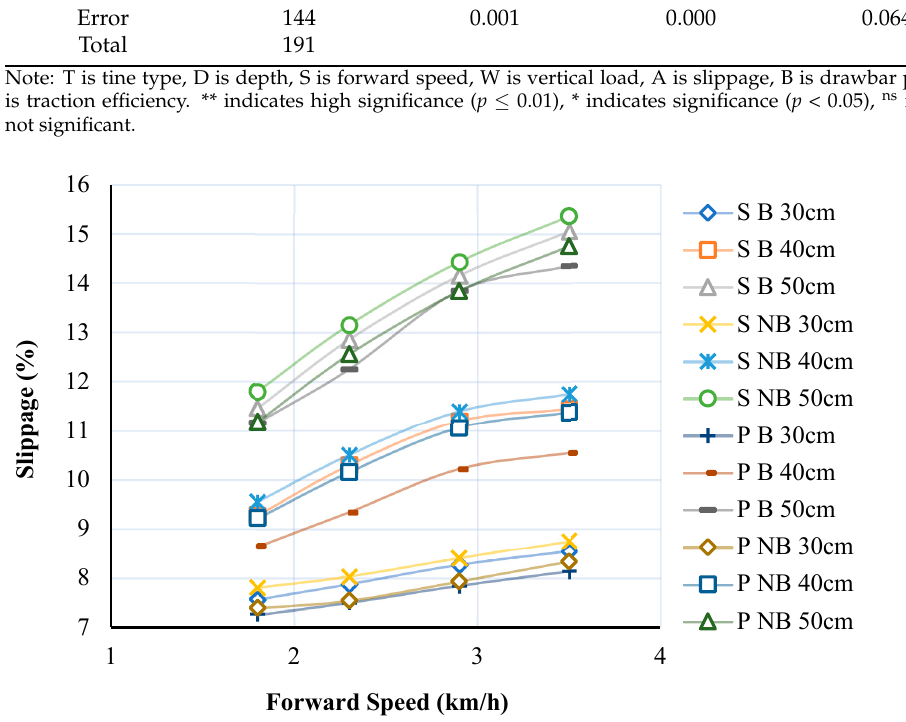
Figure 3. The relationship between speed, depth, ring weights and slippage using the studied tines (S-Subsoiler, P—Paraplow, B—225 kg vertical load, NB—No Table 2. Analysis of variance (ANOVA) of tine, depth, speed and vertical load (ring weight) on the parameters of this study (drawbar power, traction efficiency and slippage).